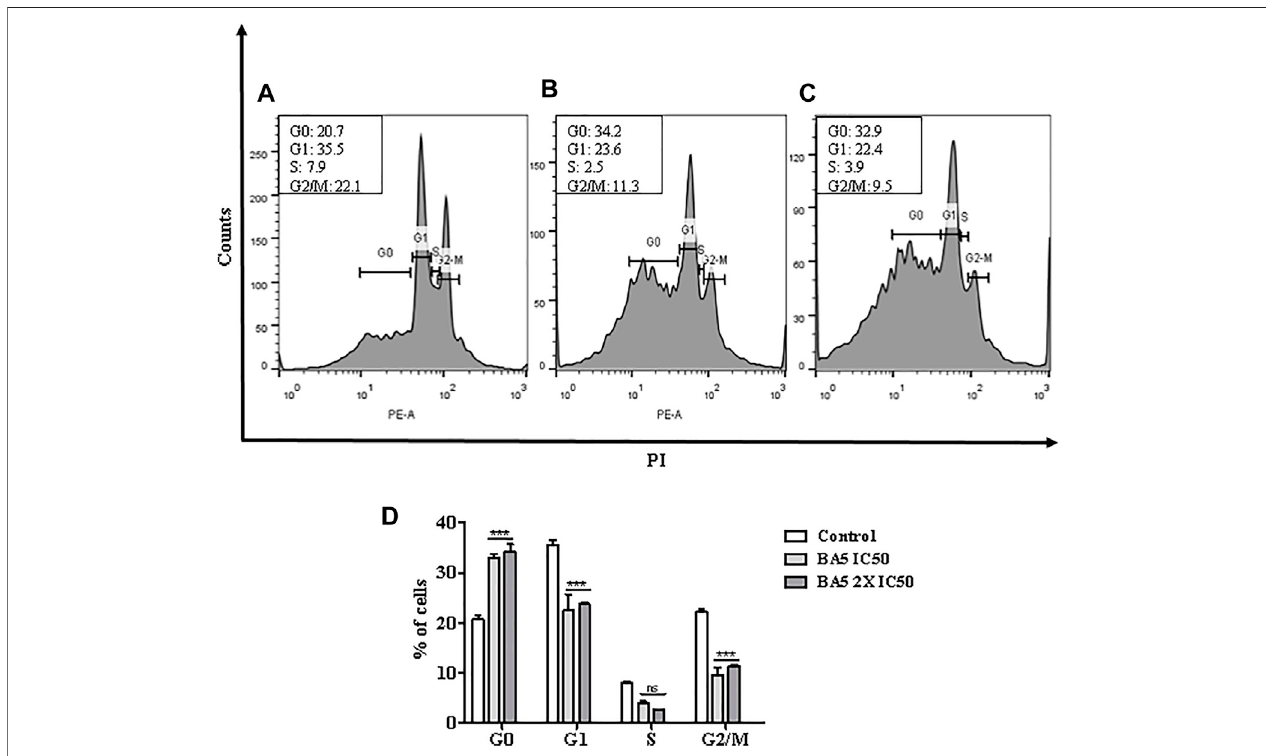
FIGURE 6 | Analysis of cell cycle progression after treatment with BA5 using propidium iodide by fl ow cytometry. The distribution and percentage of parasites in pre-phase G0, G1, S and G2/M phase of the cell cycle are indicated. Cells treated with IC 50 value (B) , and 2x IC 50 value (C) concentrations of BA5, compared to untreated control (A) . (D) Percentage of cells in different phases of cell cycle. Values represent the means ± S.E.M. of three determinations obtained in one of two experiments performed. *** p < 0.001 compared to stimulated and untreated cells.